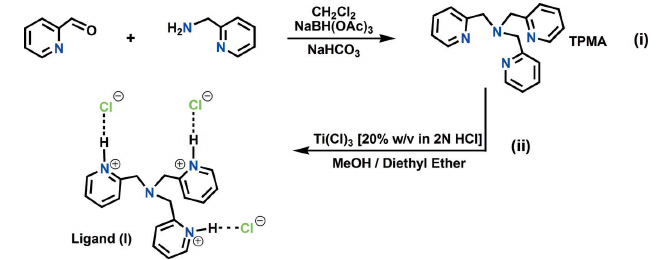
Figure 2 Synthetic scheme for the title compound, [C 18 H 21 N 43+ (cid:2) Cl (cid:3) ] ( 1